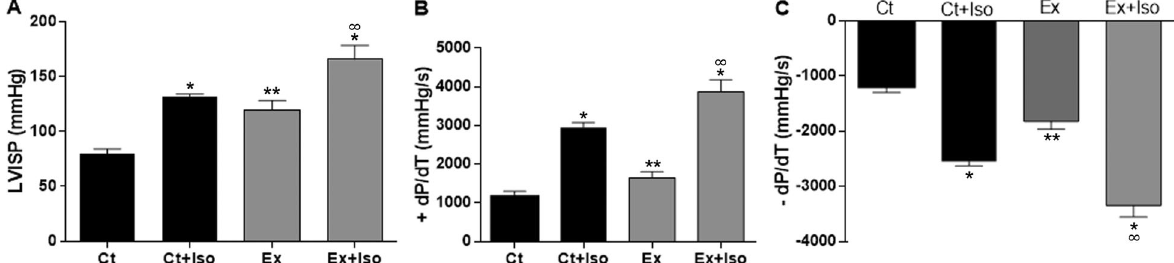
Figure 3. Effect of b -adrenergic activation by isoproterenol [Iso (100 m L, 10 m M, in bolus)] in the Langendorff apparatus on ( A ) left ventricular isovolumetric systolic pressure (LVISP), ( B ) positive fi rst time derivative ( + dP/dt), and ( C ) negative fi rst time derivative ( (cid:1) dP/dt) from control (Ct, n=6) and exercised (Ex, n=6) spontaneously hypertensive rats (SHR). Results are reported as means ± SE. *P o 0.05, vs baseline condition; **P o 0.05 vs Ct, N P o 0.05 vs Ct + Iso (one-way ANOVA).